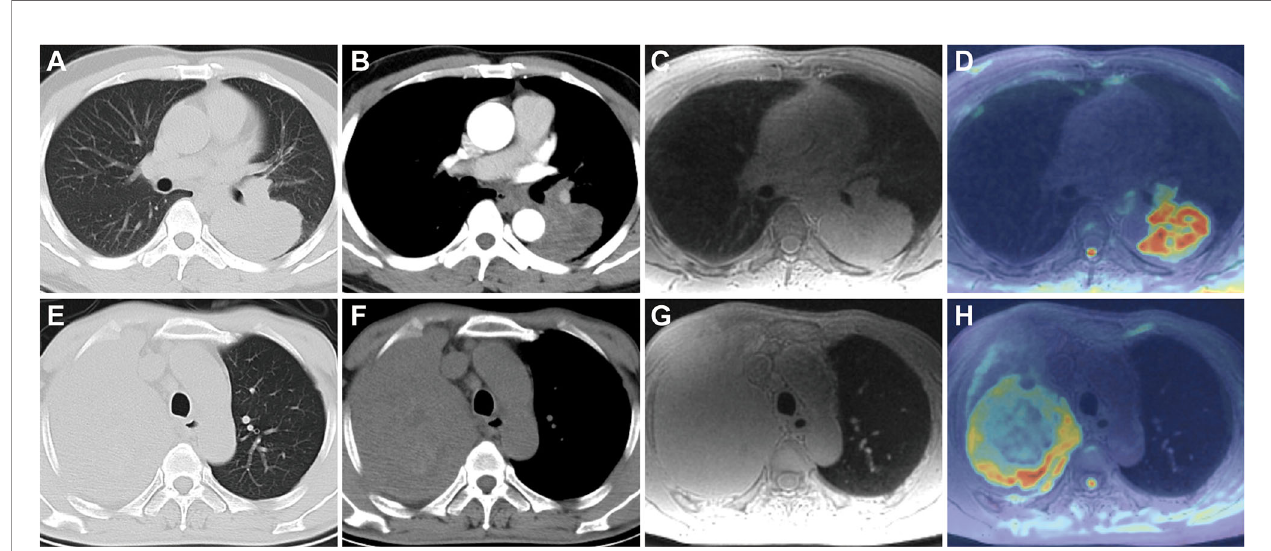
FIGURE 7 | Lung CT and MRI images of two patients without or with signi fi cant inter-modality variation of volume. A 48-year-old man with lung adenocarcinoma in the left lower lobe on axial CT lung window (A) , mediastinal window (B) , and ZTE-MRI (C) ; ADC map (D) showed the consistent lesion extent with ZTE-MRI and CT; a 59-year-old man with lung adenocarcinoma in the right upper lobe on axial CT lung window (E) , mediastinal window (F) , and ZTE-MRI (G) ; ADC map (H) shows the actual lesion extent which was inconsistent with ZTE-MRI; it is confusing to distinguish the boundary between the non-smooth lesion and surrounding lung tissue with obstructive atelectasis on